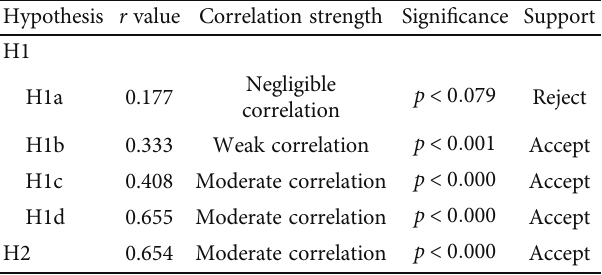
Table 3: Summary of hypothesis